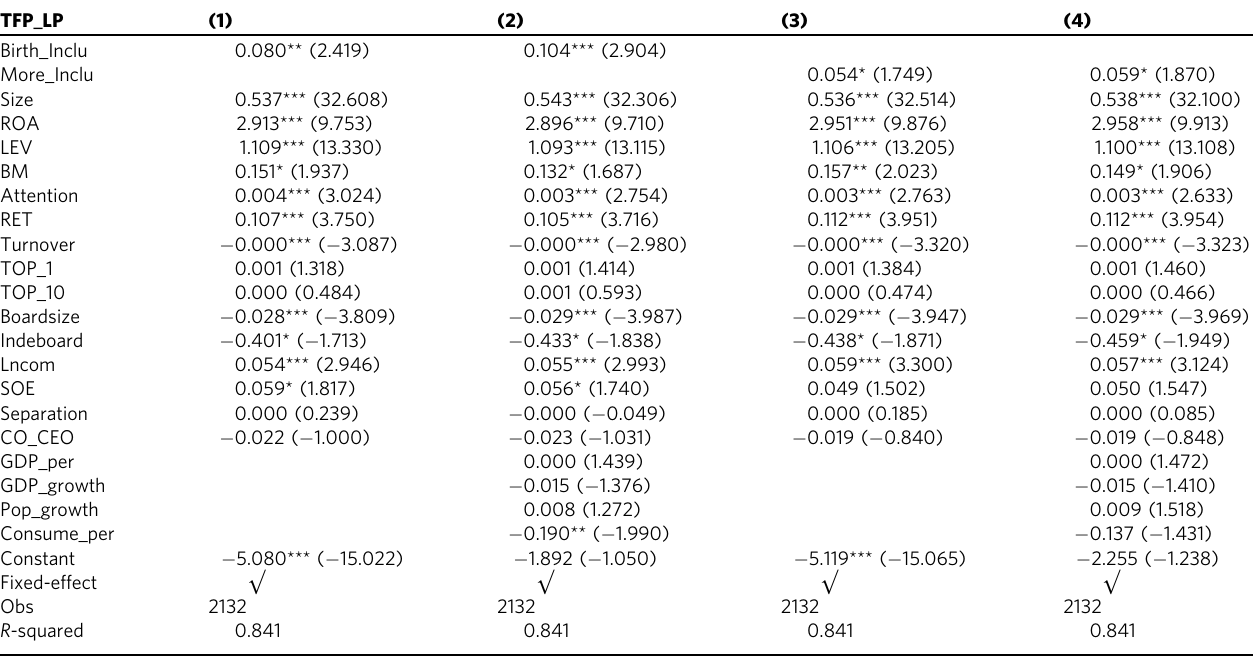
Table 8 The role of corporate top managers in transmitting cultural inclusion.